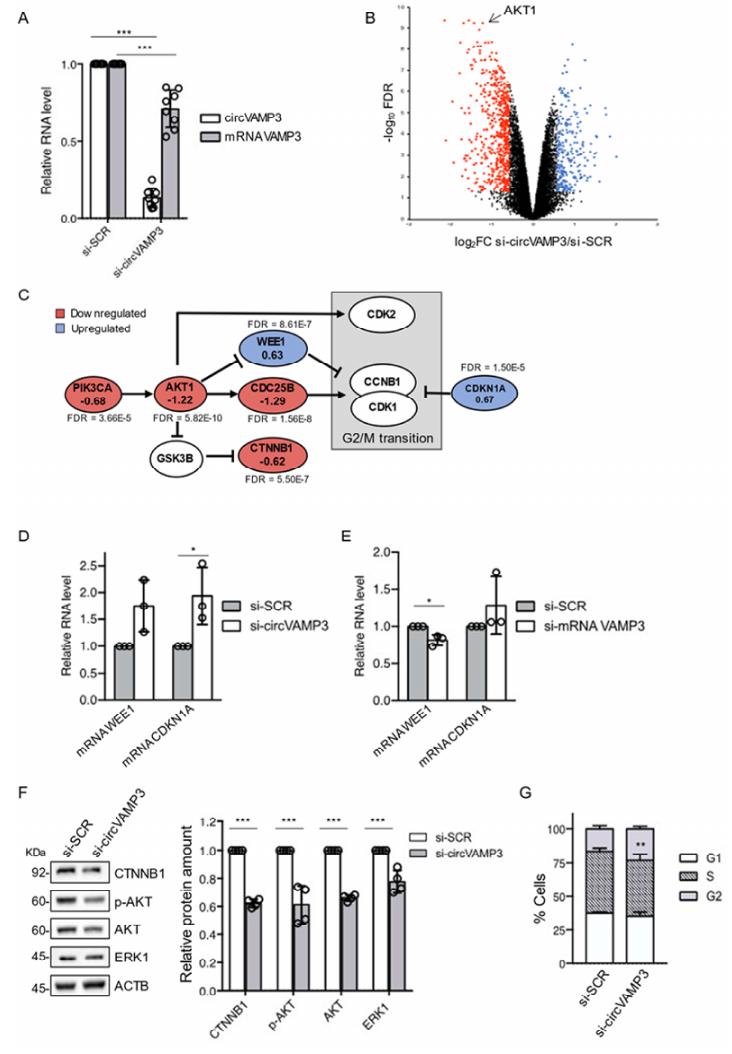
Figure 3. ( A ) Relative levels of RNA detected by qRT-PCR of circVAMP3 and VAMP3 mRNA in RH4 cells treated with si-SCR or si-circVAMP3. Data are represented as mean of fold changes ± standard deviation of 8 biological replicates, with dots representing individual datapoints. ( B ) Volcano plot showing genes differentially expressed in RH4 cells treated with si-circVAMP3 vs si-SCR. In blue, genes with a log 2 fold change (FC) greater than 0.58 and an FDR lower than 0.05. In red, genes with a log 2 FC lower than − 0.58 and an FDR lower than 0.05. AKT1 gene is indicated by an arrow. ( C ) Cartoon depicting the relation of several proteins belonging to the AKT pathway and its relationship with the G2/M transition pathway; proteins downregulated at the RNA level upon circVAMP3 knock-down are coloured in red, while the upregulated ones are coloured in blue. The numbers in the circle represent the log 2 FC, and the FDR is indicated below each circle. ( D , E ) Relative levels of RNA detected by qRT-PCR of WEE1 and CDKN1A transcripts in RH4 cells treated with si-SCR and either si-circVAMP3 ( D ) or si-mRNA VAMP3 ( E ). Data are represented as mean of fold changes ± standard deviation of three biological replicates, with dots representing individual datapoints. ( F ) Left panel: Western blot in RH4 cells treated either with si-SCR or si-circVAMP3 to detect CTNNB1, phosphorylated-AKT (p-AKT), AKT, ERK1 and ACTB (loading control) protein levels. Protein molecular weights (KDa) are indicated on the left; the panel shows a representative experiment of four. Right panel: Quantification of protein levels (relative to ACTB) from the experiment shown in the left panel. Data are represented as mean of relative protein levels ± standard deviation of four biological replicates, with dots representing individual datapoints. ( G ) Cell cycle analysis by flow cytometry (FACS) of RH4 cells upon control treatment (si-SCR) or circVAMP3 knock-down (si-circVAMP3). Data are represented as mean % cells in each cell cycle phase ± standard deviation of four biological replicates. Where statistical analysis was performed, the ratio of each sample versus its experimental control was tested by a two-tailed unpaired Student’s t -test. *: p -value < 0.05, **: p -value < 0.01, ***: p -value < 0.001, ****: p -value <